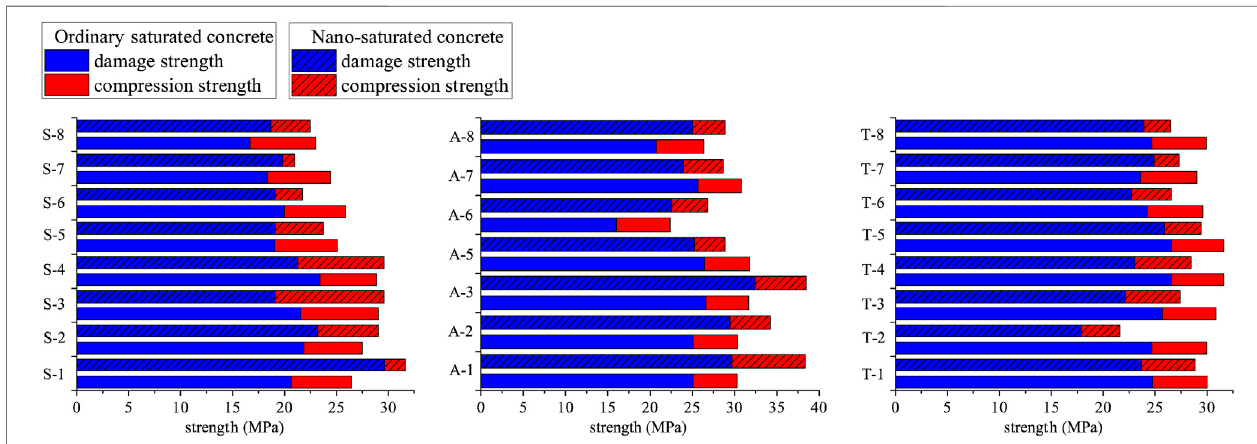
FIGURE 10 | Comparison of damage strength of various types of saturated concrete samples.